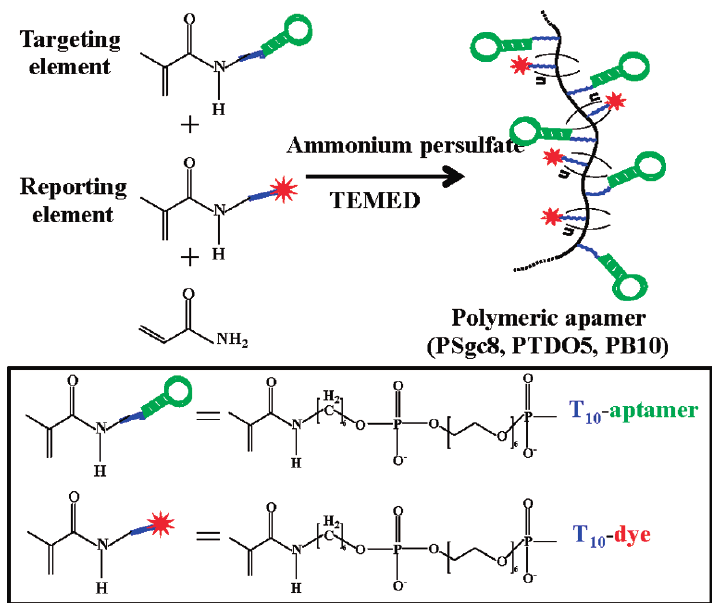
Scheme 8. Schematic of polymeric aptamer synthesis. Reproduced with permission from Reference [156].